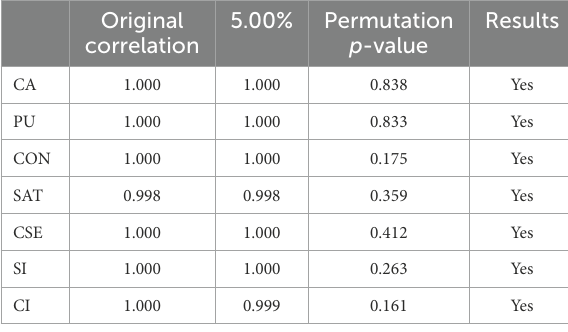
TABLE 11 Measurement invariance test using MICOM.